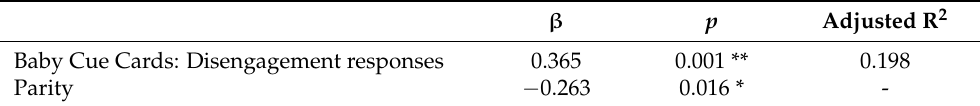
Table 4. Results of regression analysis conducted to examine the associations of the EPDS total score with the demographic variables and scores on the social cognitive tests.